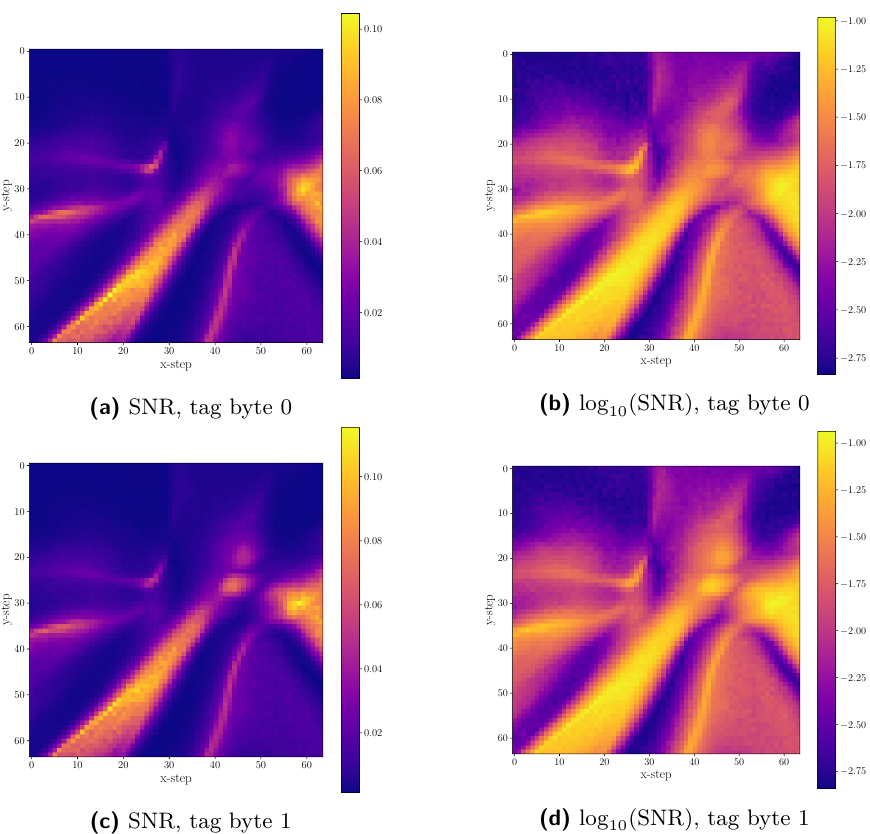
Figure 15: Heatmaps on Cortex-M4 (128-bit arch) for various tag